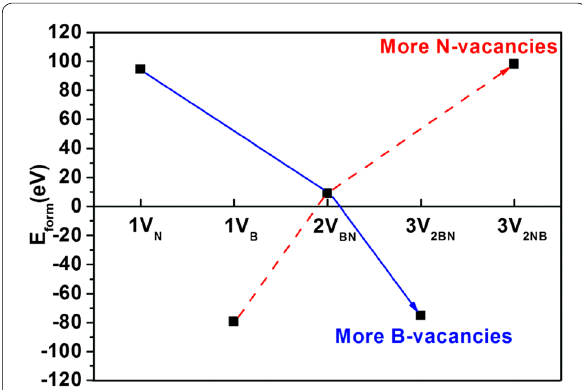
Fig. 6 Plot of E form with respect to vacancy density. Monolayer h‑BN with more B vacancies is energetically preferable to be formed even under the same vacancy